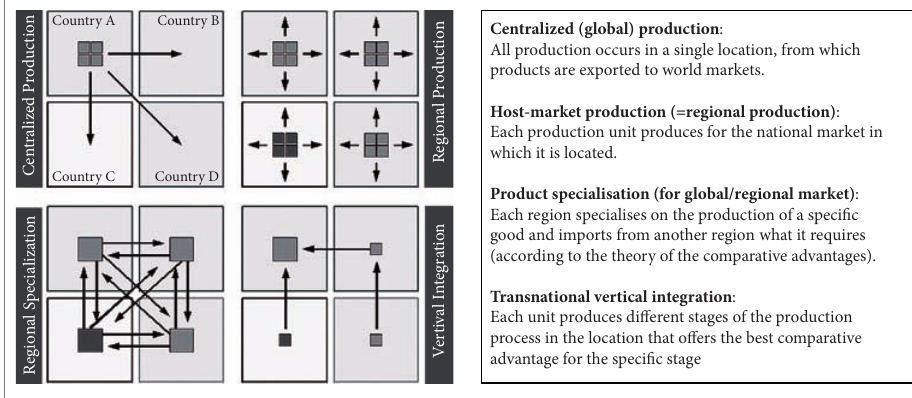
Fig. 1. Geographical organisation of production Units. Source: adapted from Knox et al.